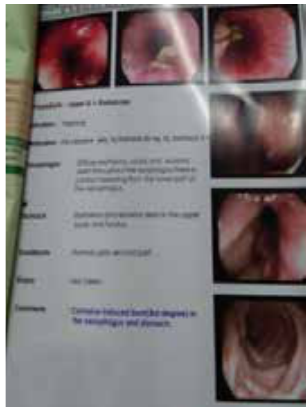
Fig 3. Endoscopy of upper gastrointestinal tract showing corrosive-induced burn (3 rd degree) in the esophagus and